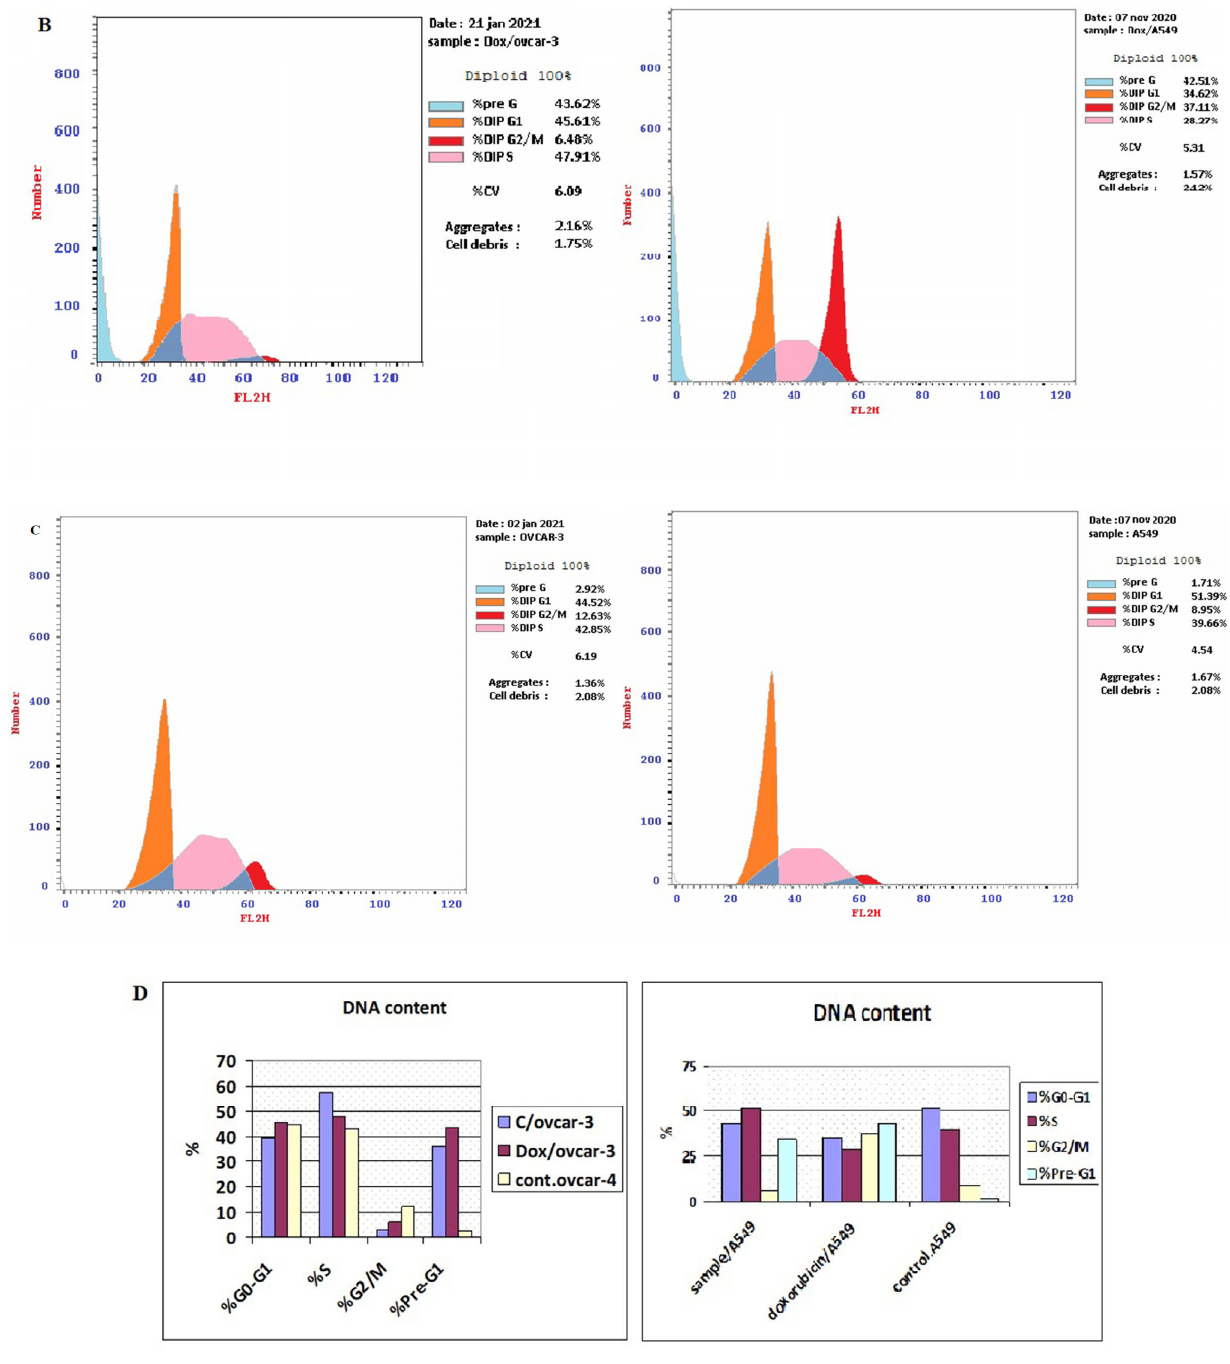
Figure 3. Cell cycle analysis of CMB and Doxorubicin treated OVCAR − 3 and A − 549 cells: ( A ): Treatment of OVCAR − 3 and A − 549 cells with CMB (IC 50 ) for 48 h. ( B ): Treatment of OVCAR − 3 and A − 549 cells with doxorubicin (IC 50 ) for 48 h. ( C ): OVCAR − 3 and A − 549 untreated control cells. ( D ): DNA content in each stage of cell cycle following treatment with CMB and doxorubicin (IC 50 ) for 48 h.